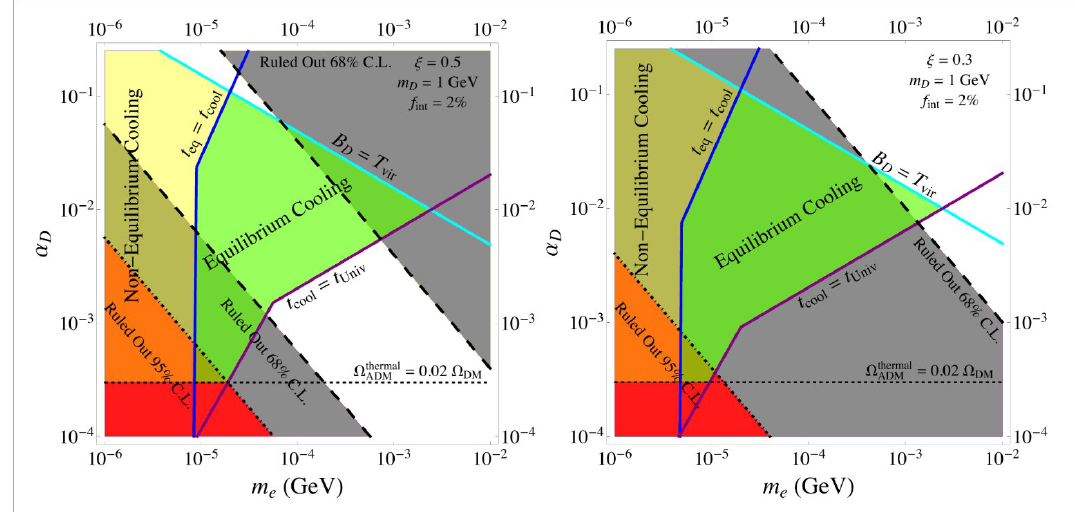
= 1GeV assuming ξ = 0.5 H (cid:48) = α (cid:48) . D